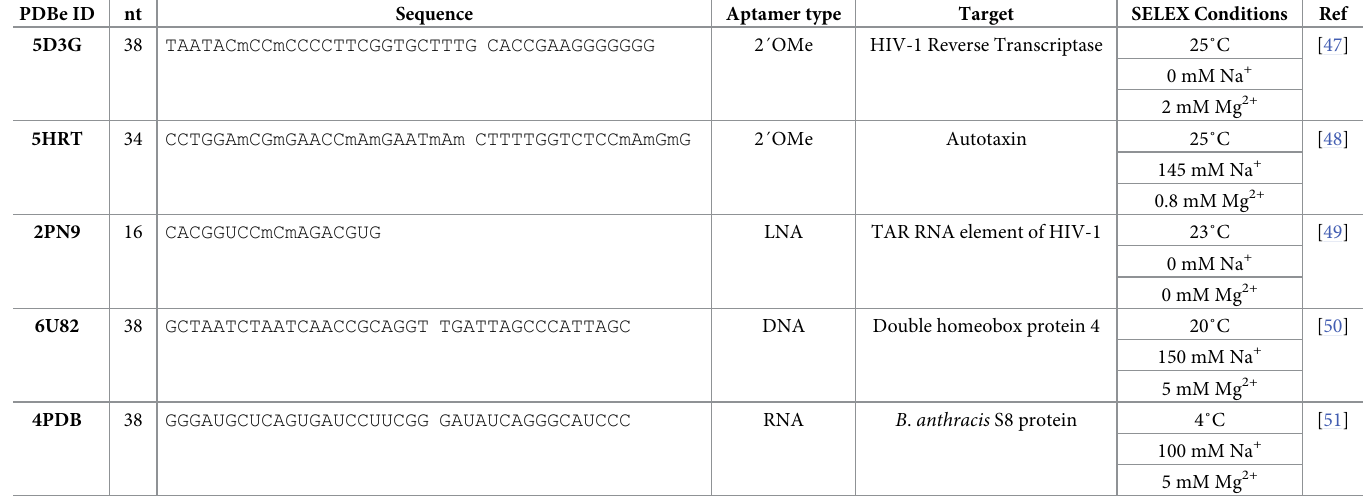
Table 1. Aptamer models selected to validate the assembled workflow. The position of the modified residues is identified in the sequence with "m" preceding the respective nucleotide. The SELEX conditions were used as input on step 1 of the workflow. PDBe